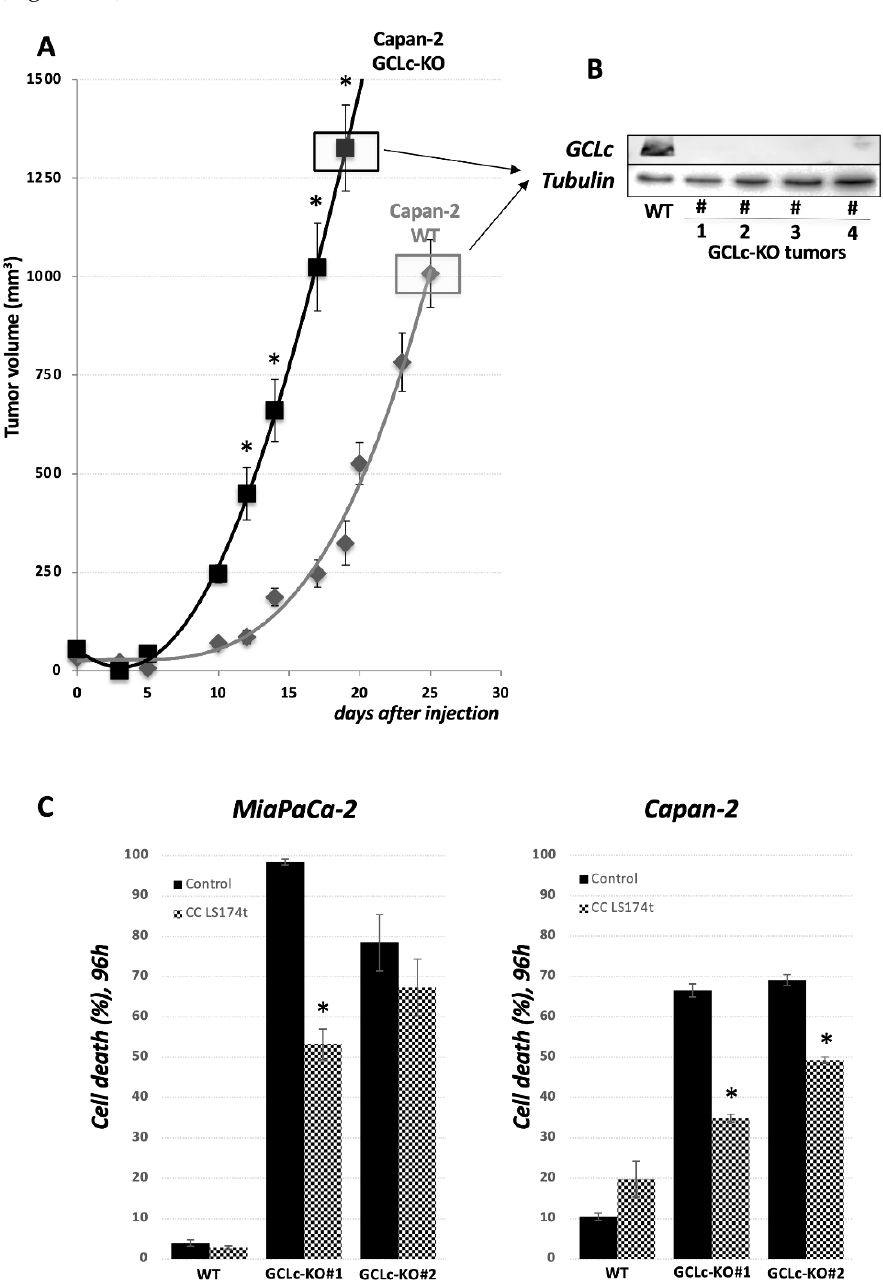
Figure 6. GCL is dispensable for tumor growth of PDAC cell lines in mice. ( A ). Tumor volumes of Capan-2 WT and GCLc-KO cells, injected subcutaneously into nude mice, showed slight increase of tumor growth upon GCLc genetic deletion. ( B ). At the end of the experiment, tumors are examined for the presence of GCLc protein. No GCLc protein band was detected in tumors isolated from Capan-2 GCLc-KO group at the end of the experiment. ( C ). Cell viability of MiaPaCa-2 and Capan-2 WT and GCLc-KO, co-cultured or not with 10% of LS174T WT cells (Boyden chamber, see Material & Methods), was analyzed after 96 h. The results are presented as mean ± SEM, n = 3. * p < 0.05, comparison with corresponding cell line in control conditions.